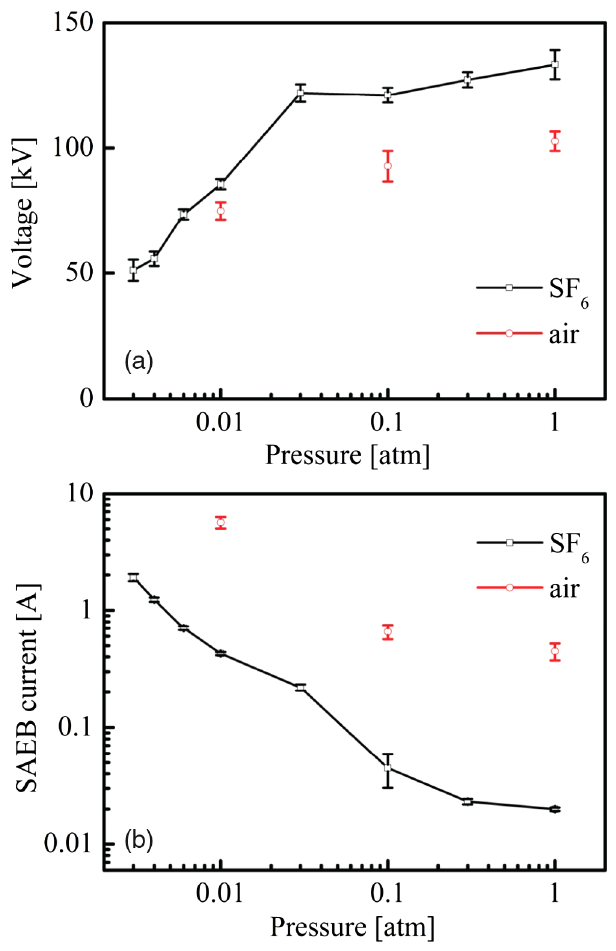
FIG. 6. Dependence of amplitude of voltage across the gap (a) and SAEB current (b) on the pressure in SF 6 and air. Interelectrode distance d ¼ 12